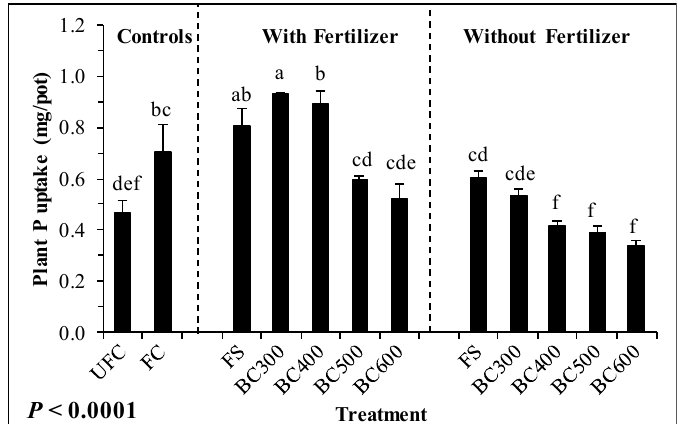
Figure 3. Plant P uptake in soil receiving 8 t ha − 1 of four date palm residue BCs produced with different pyrolysis temperatures (BC300, BC400, BC500, and BC600) and the BC FS with and without a fertilizer added. Treatments also included a UFC and an FC. Bars sharing the same letter among treatments are not significantly different according to the SNK test ( p ≤ 0.05). Errors bars represent the standard error of the mean ( n =4).